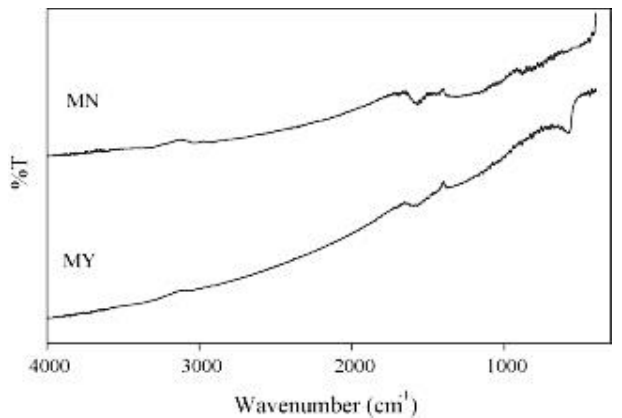
Figure 4. FTIR spectra of Fe 3 O 4 loaded activated carbon (MY) and activated carbon treated with sulfuric acid (MN). Reprinted from Liu et al. [26] Copyright 2021 Elsevier.